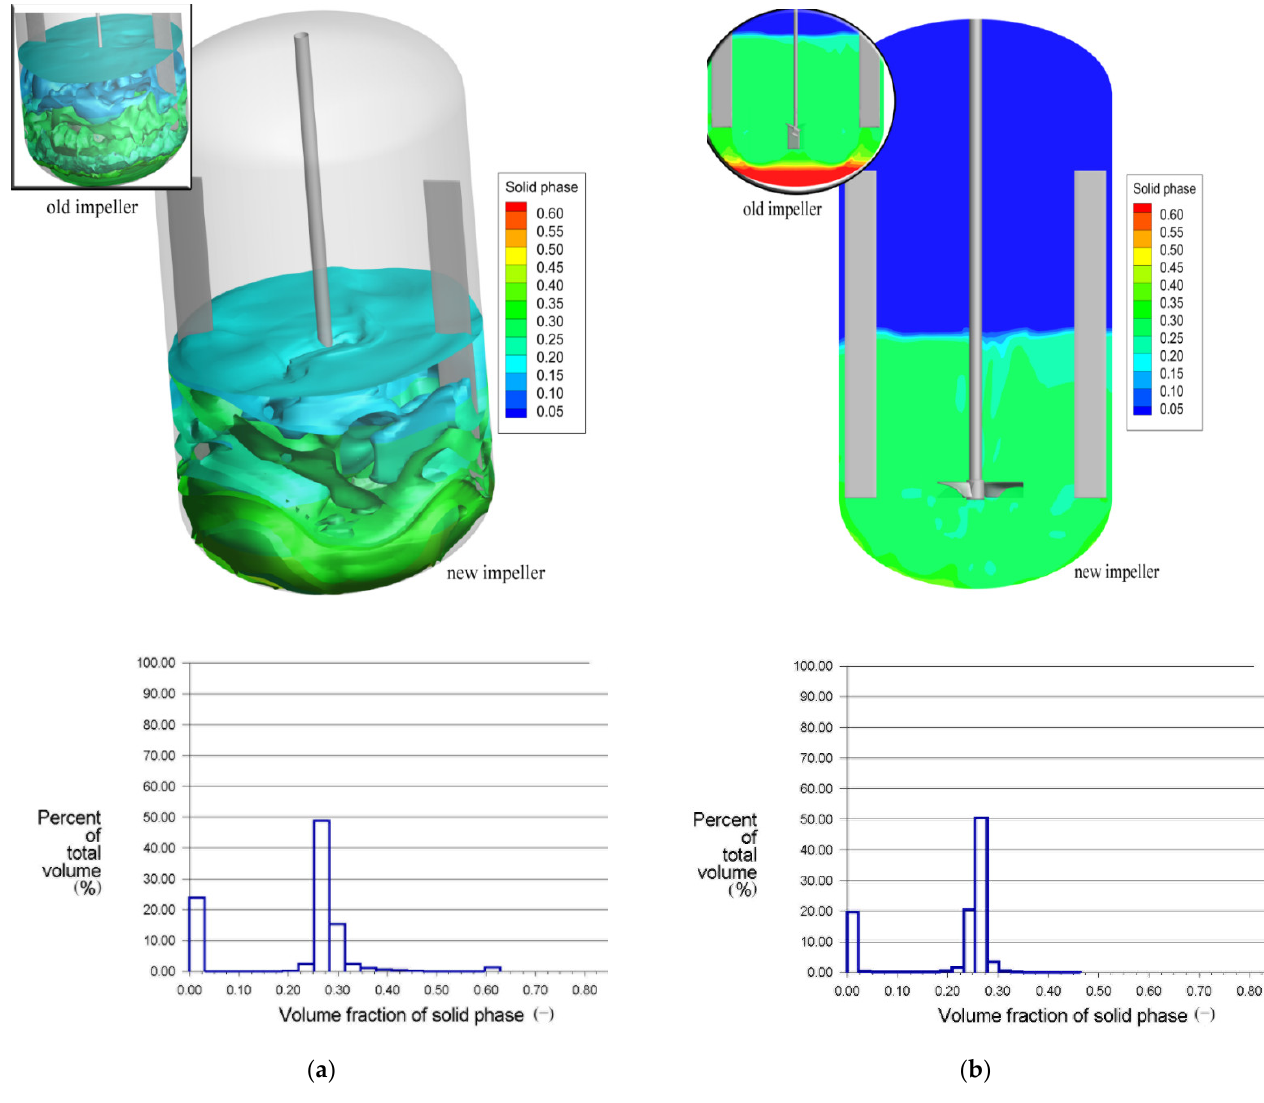
Figure 4. Final state of the volume fraction distribution of the solid phase: ( a ) old impeller; ( b) new impeller.